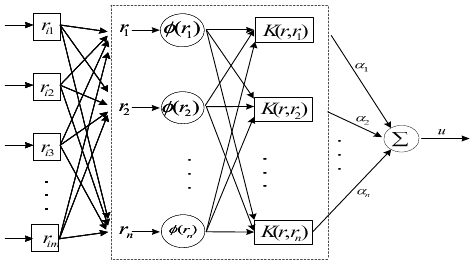
Figure 1. Schematic diagram of support vector machine for multi attribute decision-making.